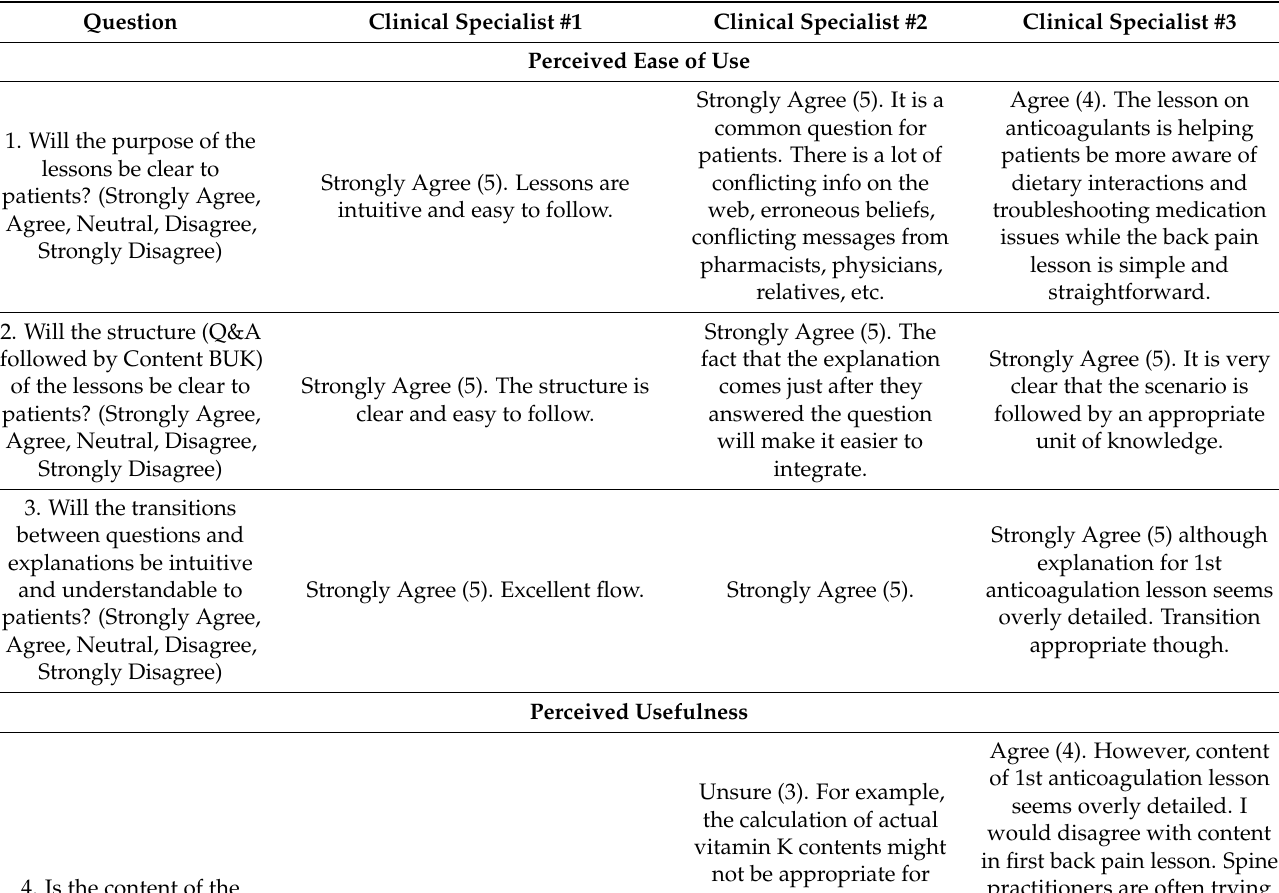
Table A1. User-centered design: feedback received from clinical specialist end-users’